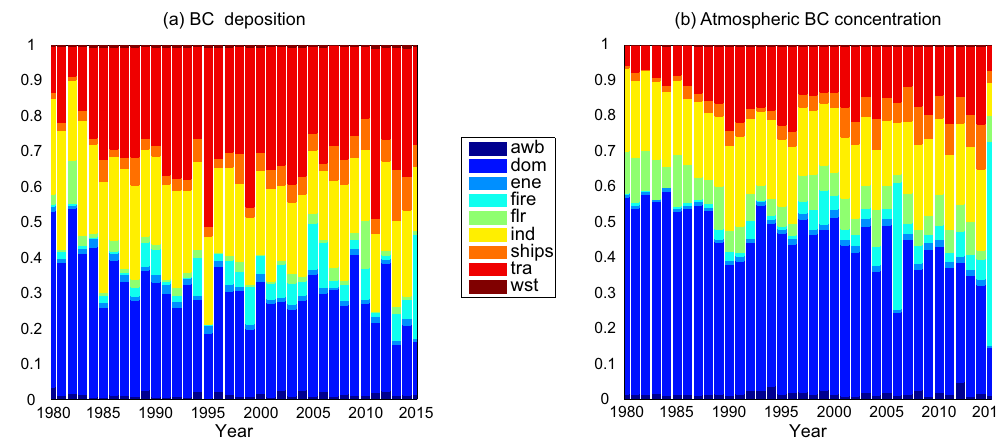
Figure 7. The annual source sector contribution to the modelled total BC deposition and atmospheric BC concentrations at Holtedahlfonna between 1980 and 2015. The sources for (a) BC deposition and (b) atmospheric BC concentrations. The emission sectors are as follows: awb is agricultural waste burning, dom is domestic, ene is energy production, fire is natural fires, flr is flaring, ind is industry, ships is shipping, tra is transport and wst is waste